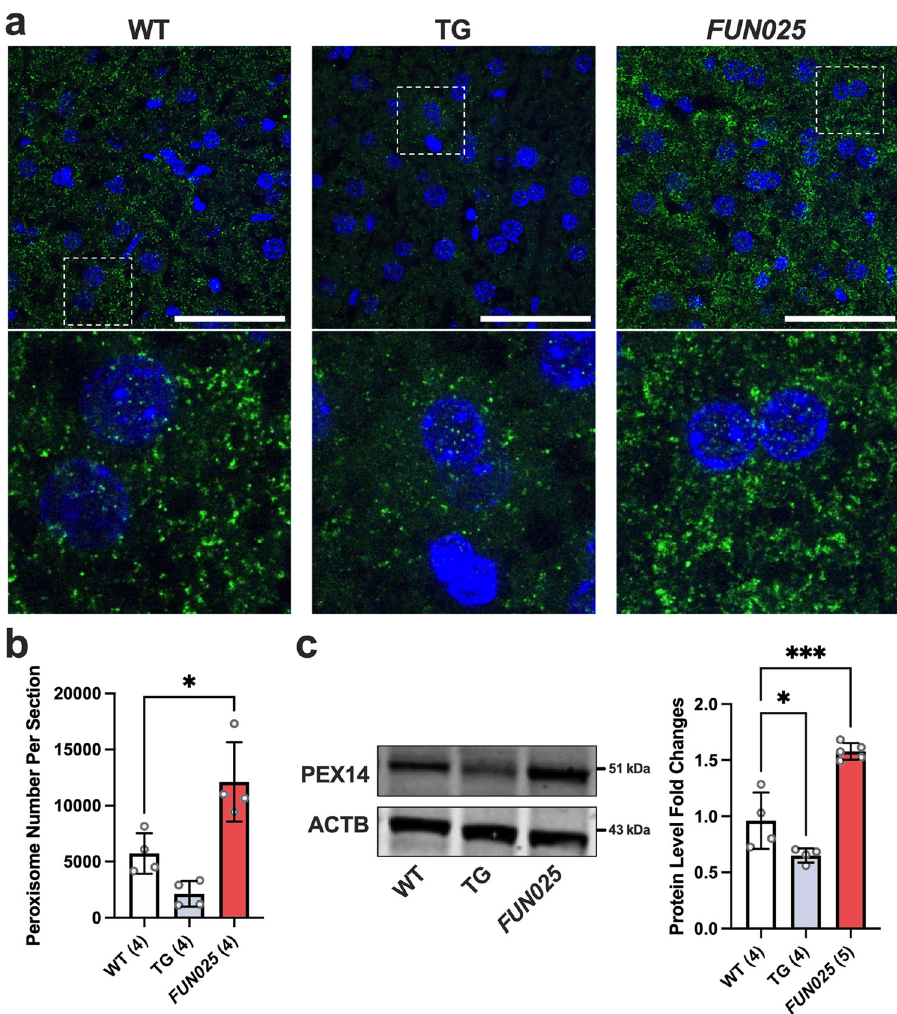
Fig. 4 TMEM135 regulates the number of peroxisome biogenesis factor 14 (PEX14) positive peroxisomes in mice. a Representative 100x immunohistochemical images of PEX14 labeled (green) and DAPI stained (blue) WT, Tmem135 TG (TG), and Tmem135 FUN025/FUN025 ( FUN025 ) livers. The white boxes in these images were expanded to highlight differences in PEX14-positive peroxisome staining between these genotypes. Scale bar for images = 50 microns. b Quantitation of PEX14-positive peroxisomes from the 100x images of WT (2 males/2 females), Tmem135 TG (1 male/3 females), and Tmem135 FUN025/FUN025 (2 males/2 females) livers using the Analyze Particles function in ImageJ. c Western blot analysis of peroxisome biogenesis factor 14 (PEX14) using livers from 2.5-month-old WT (2 males/2 females), Tmem135 TG (2 males/2 females), and Tmem135 FUN025/FUN025 (3 males/2 females) mice. ACTB served as the loading control for this Western blot experiments. Asterisks (* and ***) indicates post hoc Tukey test for a P < 0.05 and P < 0.001 signi fi cance following a signi fi cant difference detected by one-way ANOVA. Number in parentheses represent the N of independent mouse samples per genotype used in the experiment. Dots represent individual data points. The protein size next to the immunoblot images denotes the size of the immunoband measured for this analysis. Data are presented as mean ±